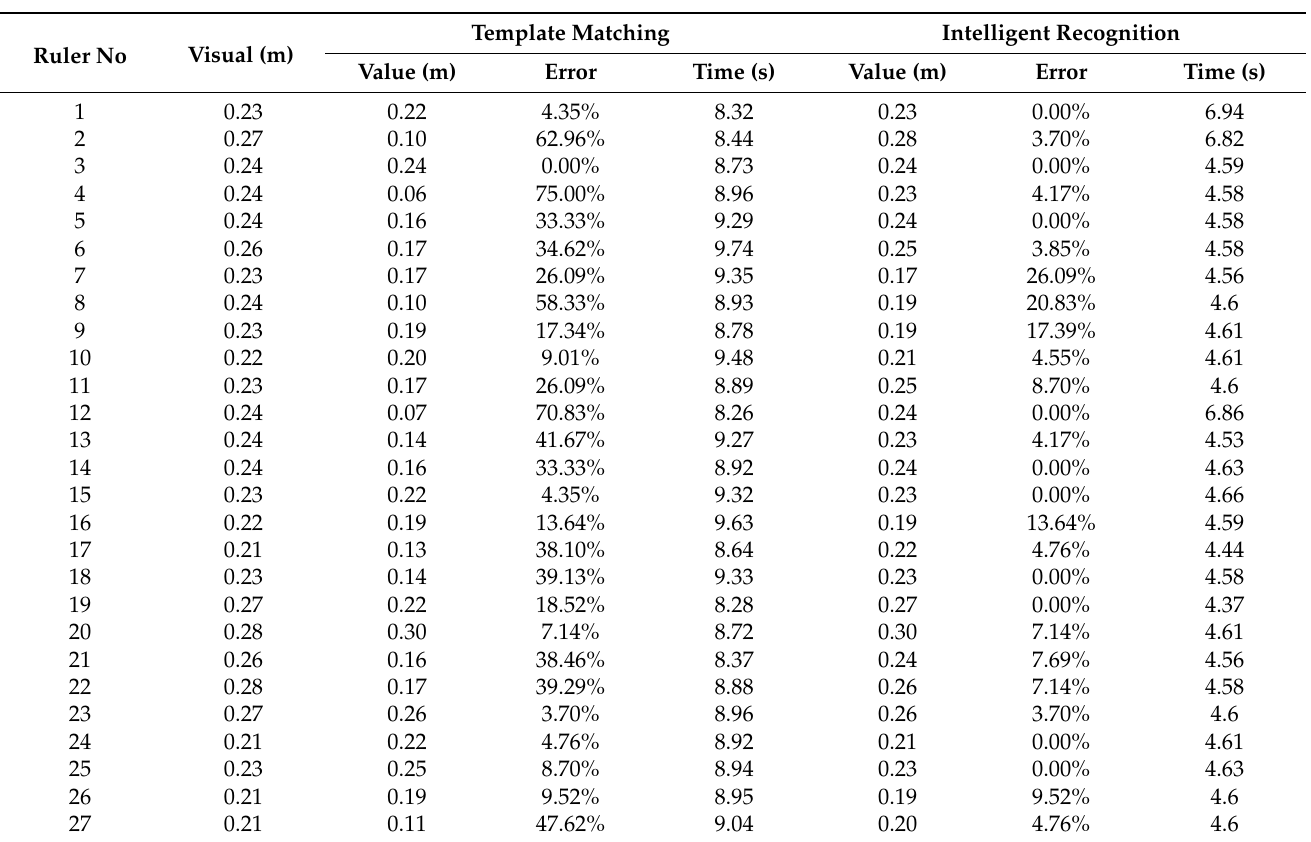
Table 2. The results of the comparison between the template matching algorithm and the intelligent recognition algorithm designed for this experiment. The accuracy and time loss of these two algo- rithms were compared using manual readings as the standard. Each of the manual readings is the average of three manual